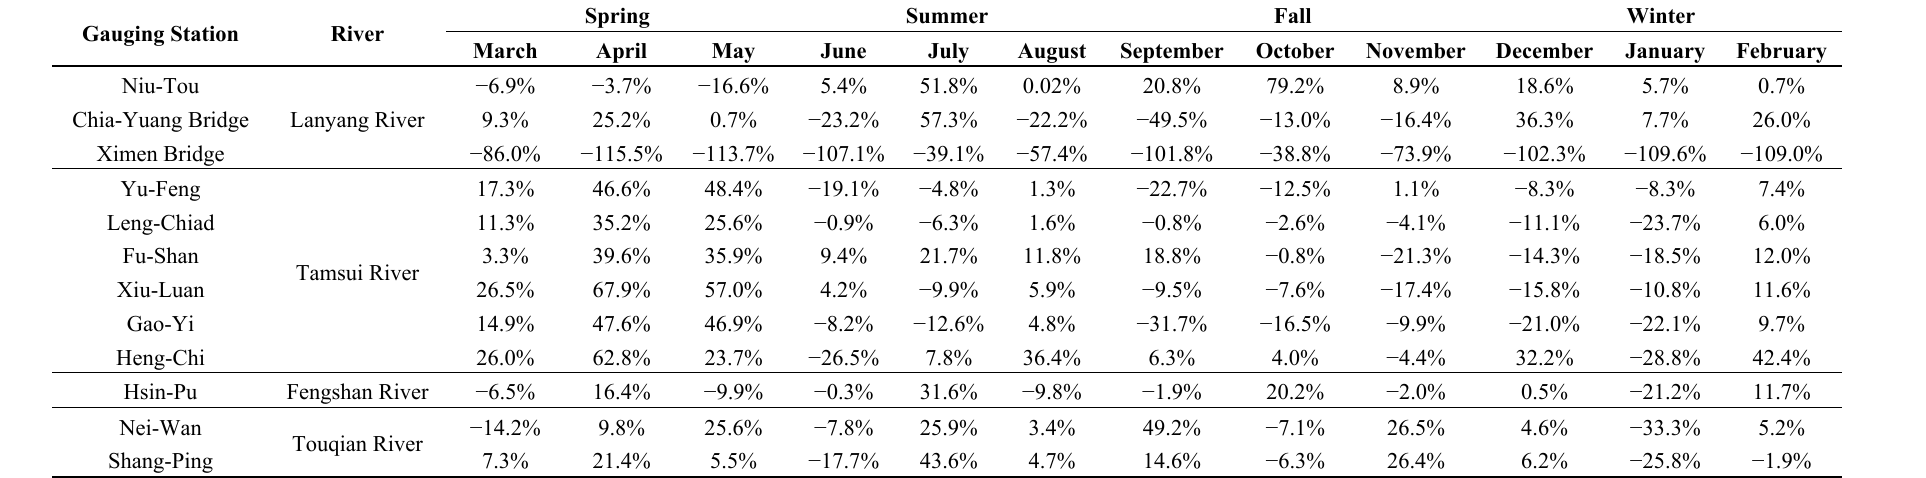
Table 5. Results for relative changes obtained using monthly mean